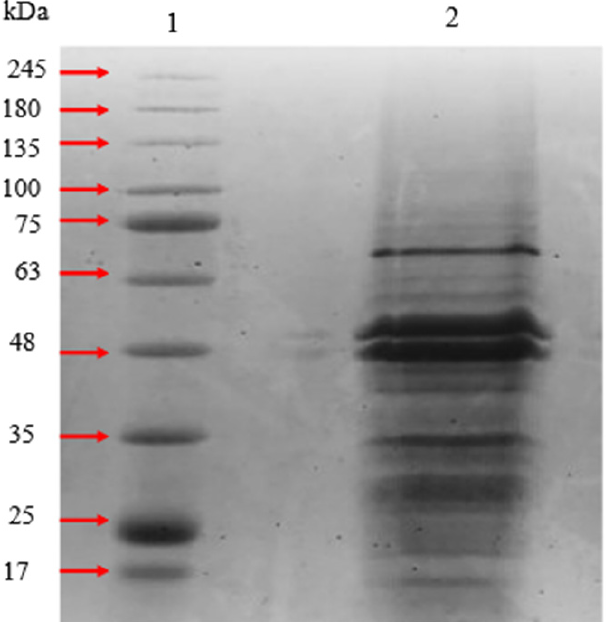
Figure 3. SDS-PAGE of crude protein samples after acetone precipitation. The fractions were boiled in reducing solubilizing sample buffer and electrophoresed on 10% SDS polyacrylamide gel at 110 V for 90 min. Lane 1 was BLUeye pre-stained protein standards and Lane 2 was the crude gingipains sample.